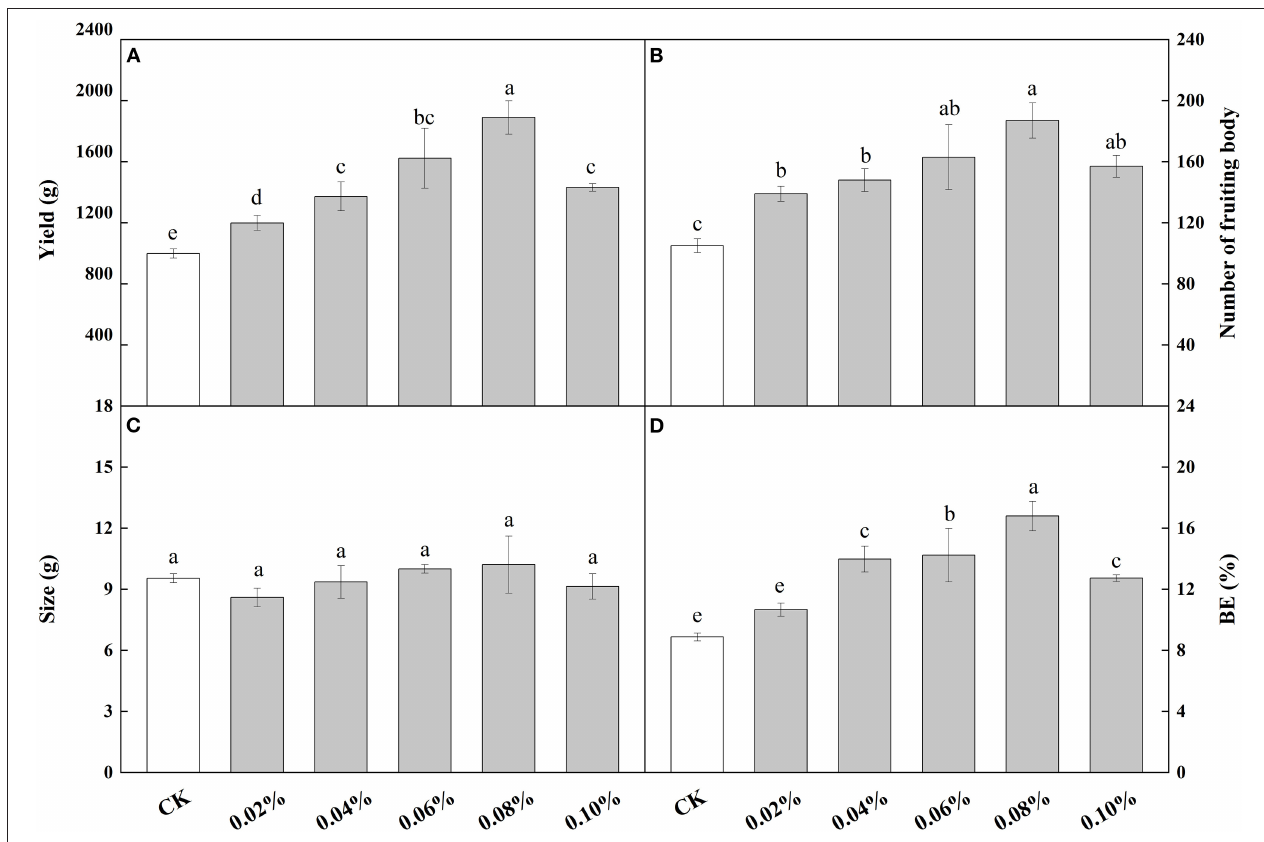
FIGURE 1 | Effects of different concentrations of NaAc on V. volvacea yield (A) , number of fruit bodies (B) , size (C) and biological efficiency, or BE (D) . Bars indicate the mean ± SD, n = 5 at each concentration, while different letters indicate treatments that differed significantly by one-way ANOVA.